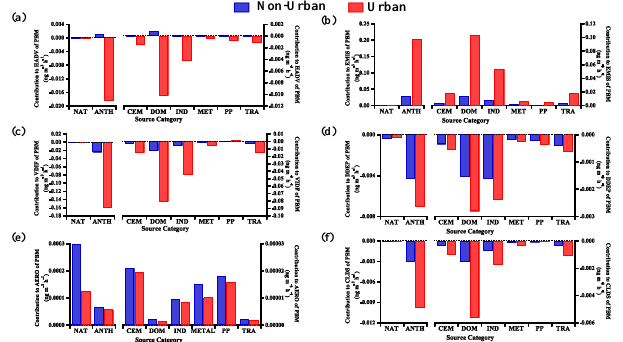
Figure 10. Impact of emission sources on (a) HADV, (b) EMIS, (c) VDIF, (d) DDEP, (e) CHEM and (f) CLDS processes of